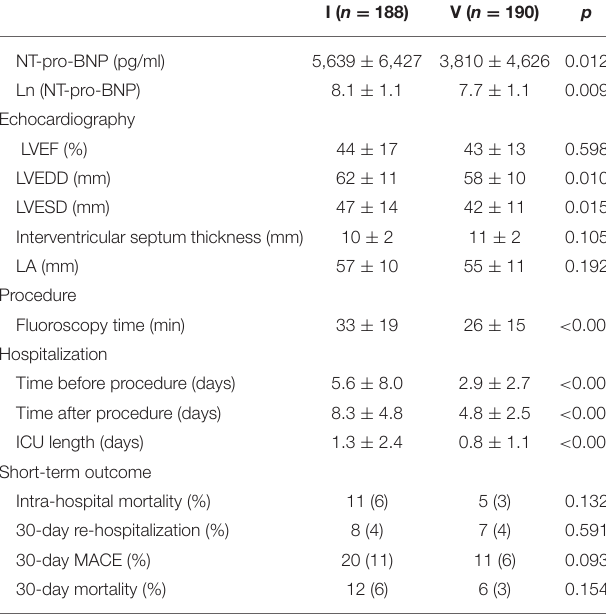
TABLE 4 | Difference between the first and last quintile in demographic characteristics and clinical